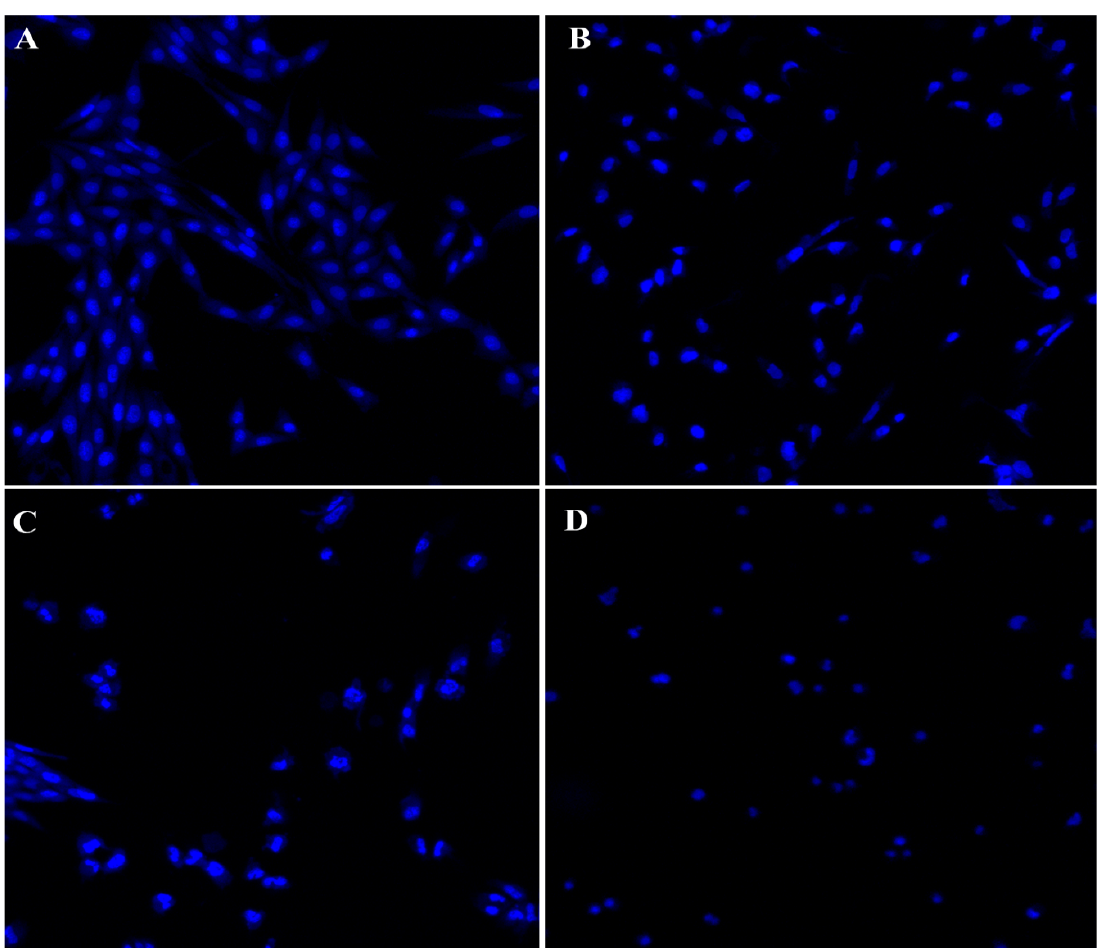
Figure 12. Impact of AgC1 on HCT-116 cells stained with DAPI after 48 h treatment: ( A ) control cell; ( B – D ) treated with 5, 10 and 20 μg/mL of Ag-C-1. Scale Bar 400 μm.